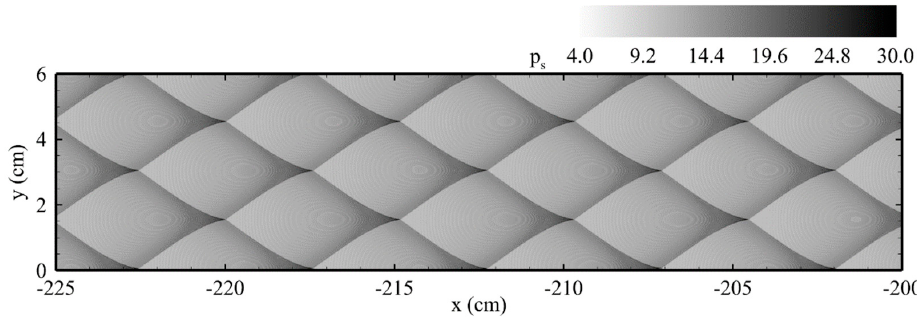
Figure 6. Smoked foil record for weakly unstable detonation case with 2H 2 + O 2 + 17Ar mixture.